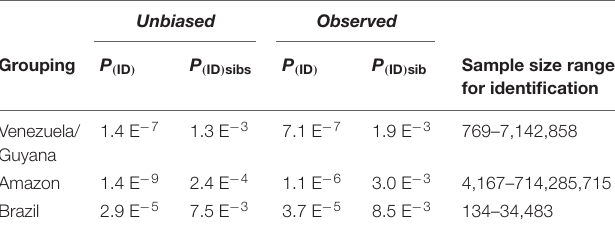
TABLE 3 | Unbiased and observed Probability of identity ( P ID ) and P ID among siblings ( P ( ID ) sib ) for each genetically identified cluster using 10